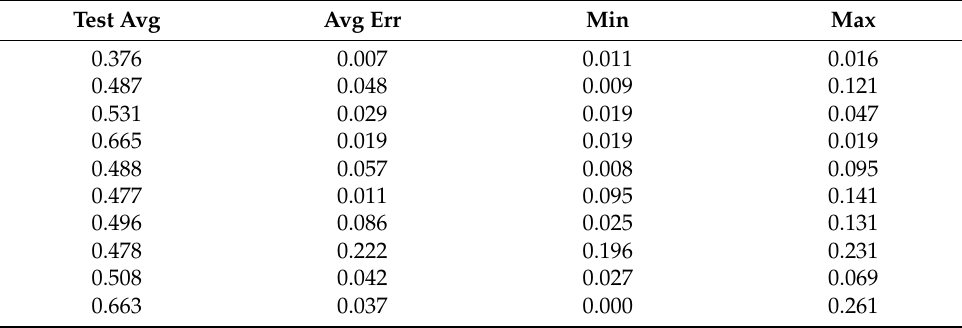
Table A206. Set 3, trials 31–40 data (actual PR